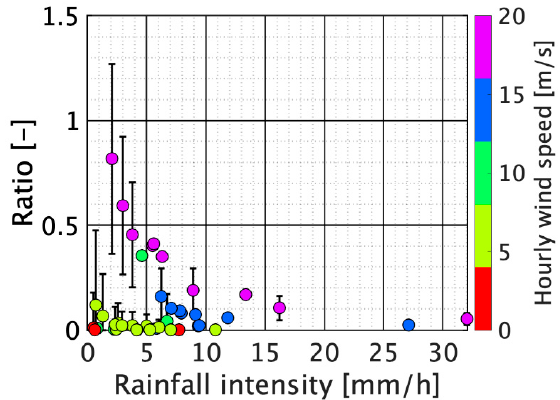
Figure 7. Relationship between rainfall intensity of R ctb and ratio of sea spray against R ctb . Bar colors indicate hourly wind speed. Black bars indicate the maximum and minimum ranges. Table 1. The parameters of the empirical equations yielding the proportions of sea spray at various rainfall intensities for different hourly wind speeds.